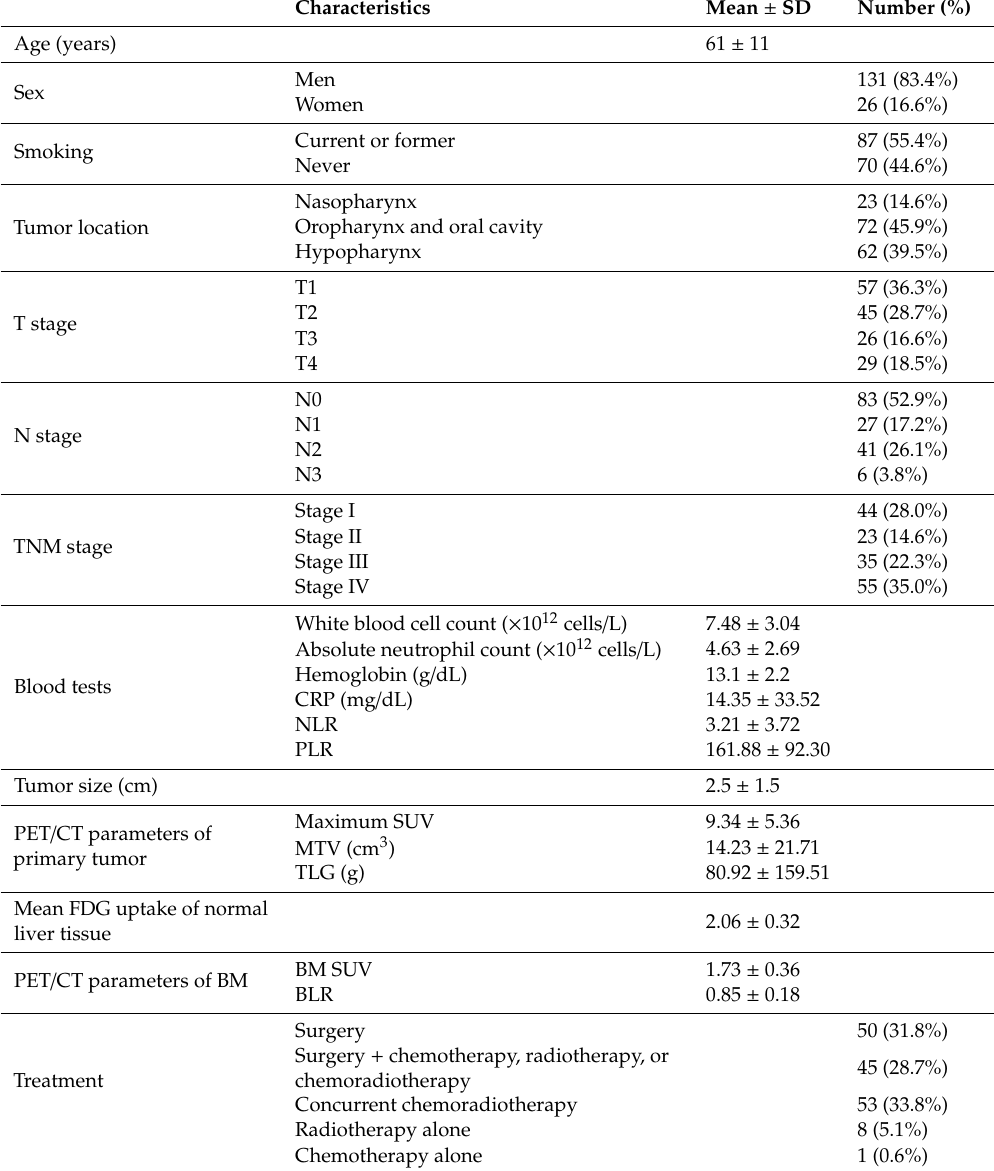
Table 1. Clinical characteristics of the patients ( n =